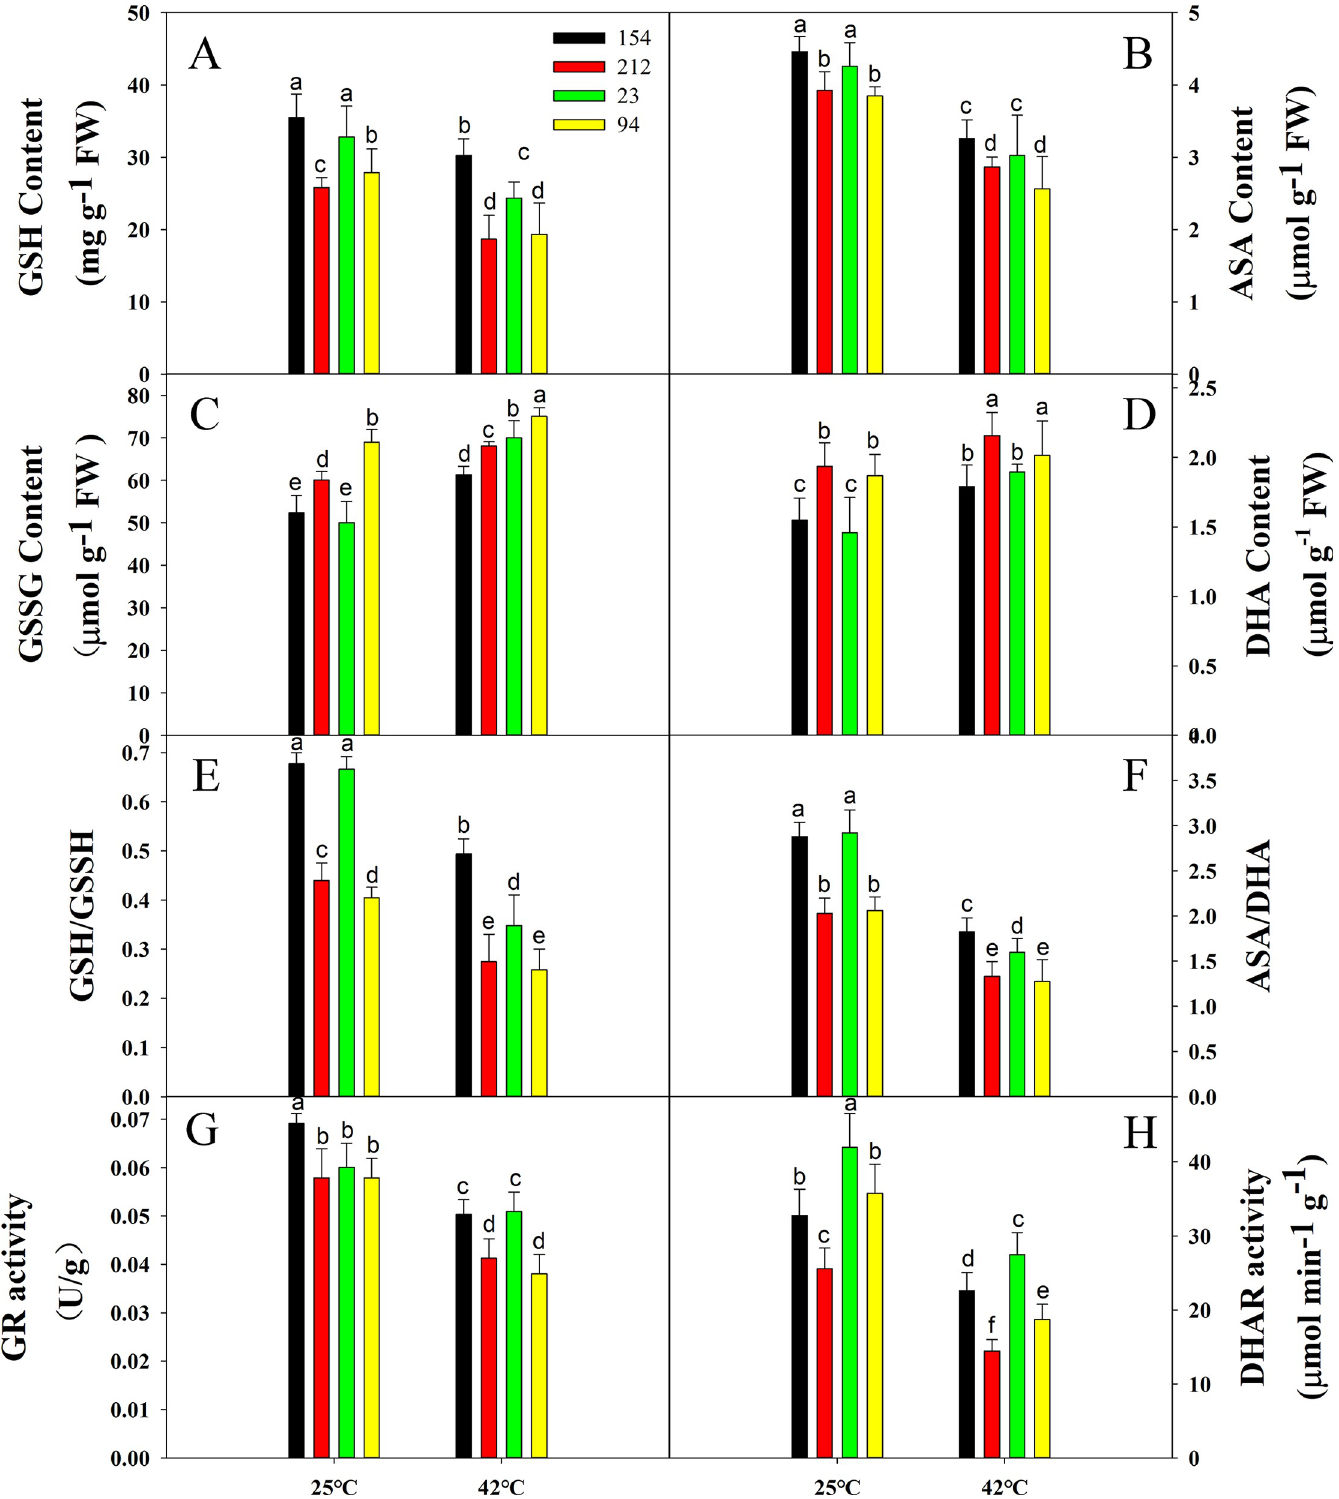
Fig 7. Effects of high temperature (treatment at 42˚C for 4 h) on the contents of (A) GSH, (C) GSSG, (B) ASA, and (D) DHA; the ratio of (E) GSH/GSSG and (F) ASA/ DHA; and the activities of (G) GR and (H) DHAR in wheat leaves. Lines 154 and 23 possess high photosynthetic rates; Lines 212 and 94 possess low photosynthetic rates. Each bar represents the mean ± SE of three independent experiments. Different letters indicate significant differences at P = 0.05.